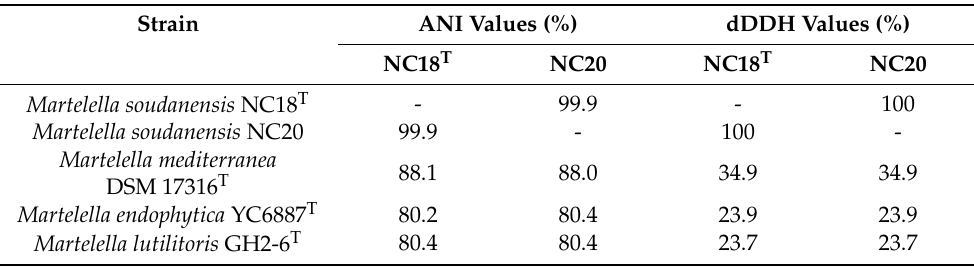
Table 4. ANI values (%) and dDDH values (%) of strains NC18 T and NC20 with related taxa within the genus Martelella . Strain ANI Values (%) dDDH Values (%) NC18 T NC20 NC18 T NC20 Martelella soudanensis NC18 T - 99.9